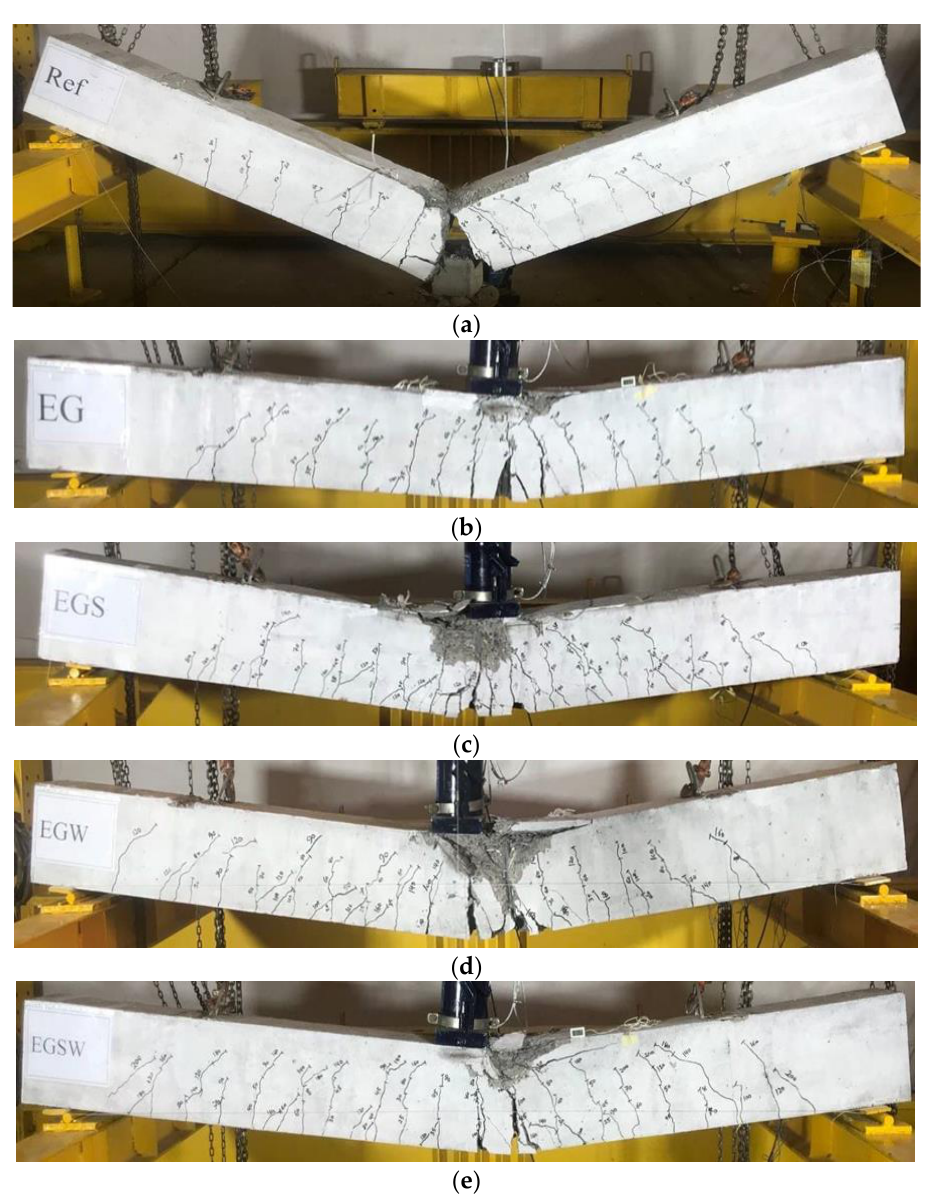
Figure 6. Failure modes of the tested beams. ( a ) Beam Ref. ( b ) Beam EG. ( c ) Beam EGS. ( d ) Beam EGW. ( e ) Beam EGSW.